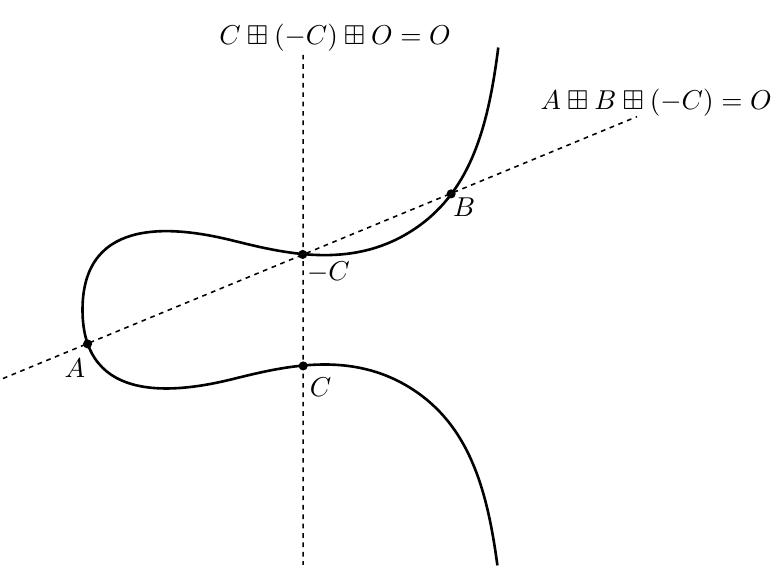
Figure 4 . Geometric construction of the Mordell-Weil group law. Each dashed line marks three points on the elliptic curve (solid curve) that add up to zero under the group law. The rational points A; B; C satisfy A (cid:1) B = C .